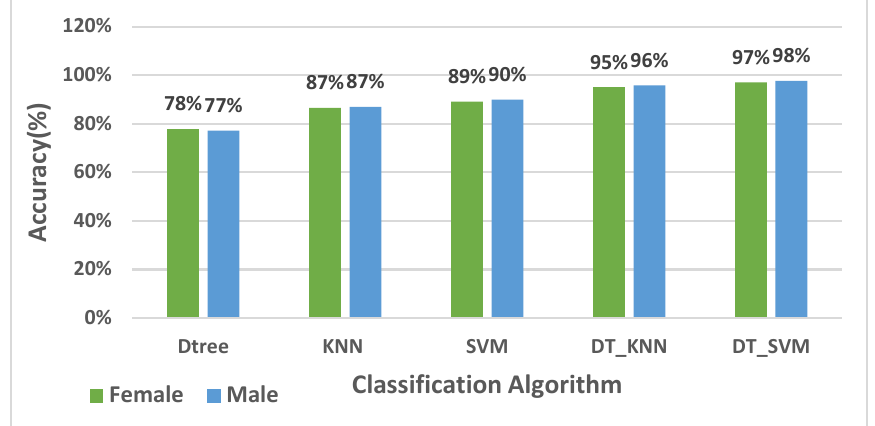
Figure 7. Comparison of the performance recognition of different algorithms based on the 5-fold cross-validation.